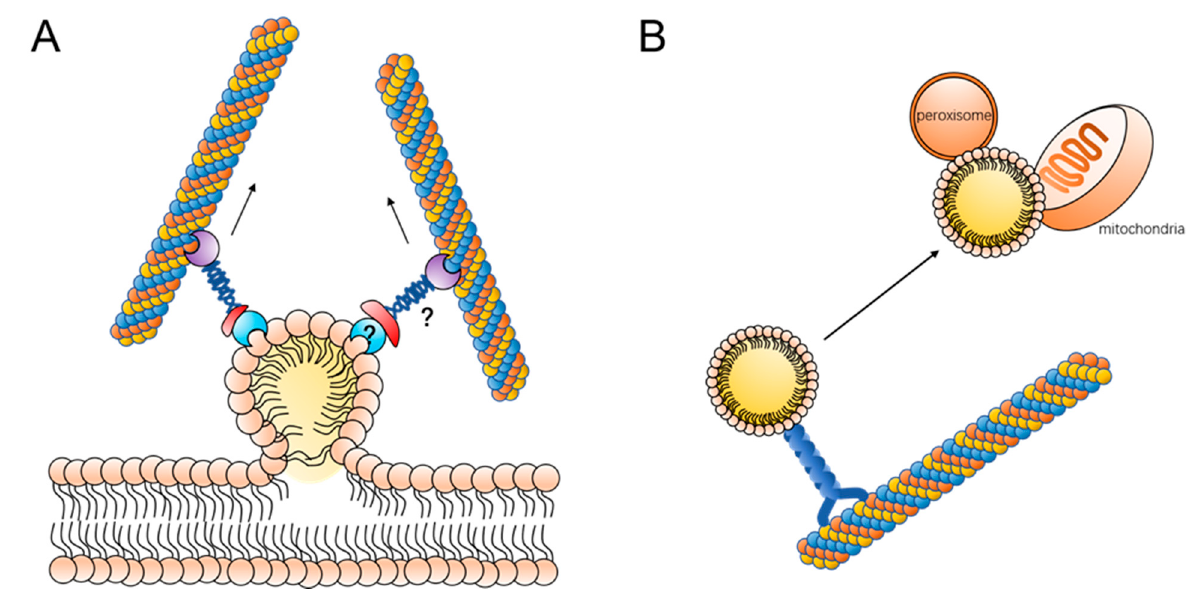
Figure 2. Motility contributes to lipid droplet metabolism: ( A ) lipid droplet moves along with microtubes, contributing to the budding process; the proteins linking lipid droplets to microtubules remain to be further elucidated, and additionally, more experimental data are still needed for microtubule proteins to target lipid droplets directly or to bind to a lipid droplet surface protein and ( B ) lipid droplet moves along with microtubes to contact with mitochondria or peroxisome.